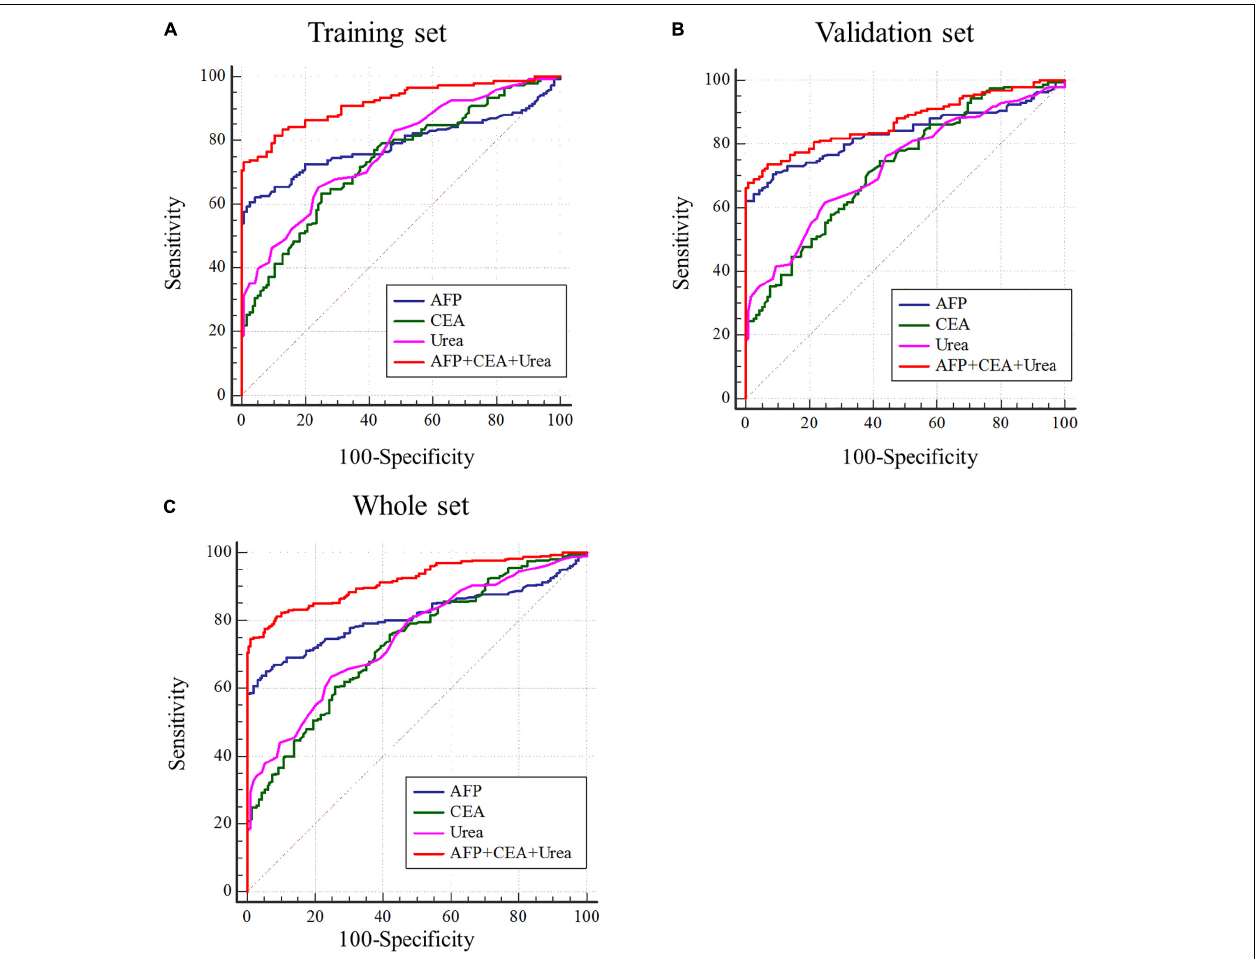
FIGURE 3 | Performance of urea, AFP, and CEA in the diagnosis of HCC. (A–C) Receiver operating characteristic curves of urea, AFP, CEA and AFP + CEA + urea to distinguish HCC from healthy controls in training set, validation set and whole set.